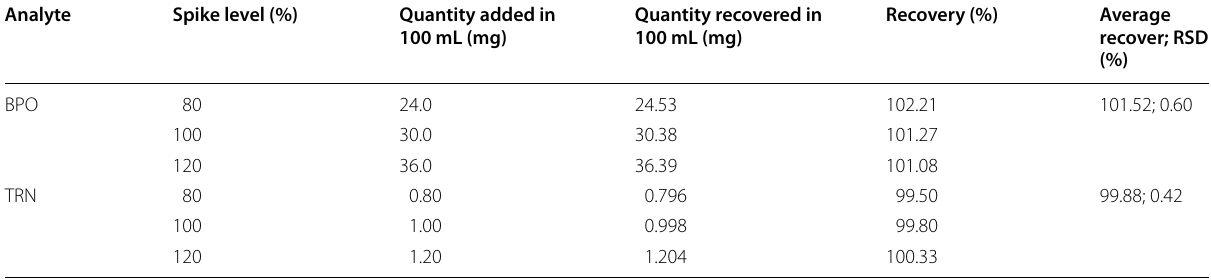
Table 4 Accuracy